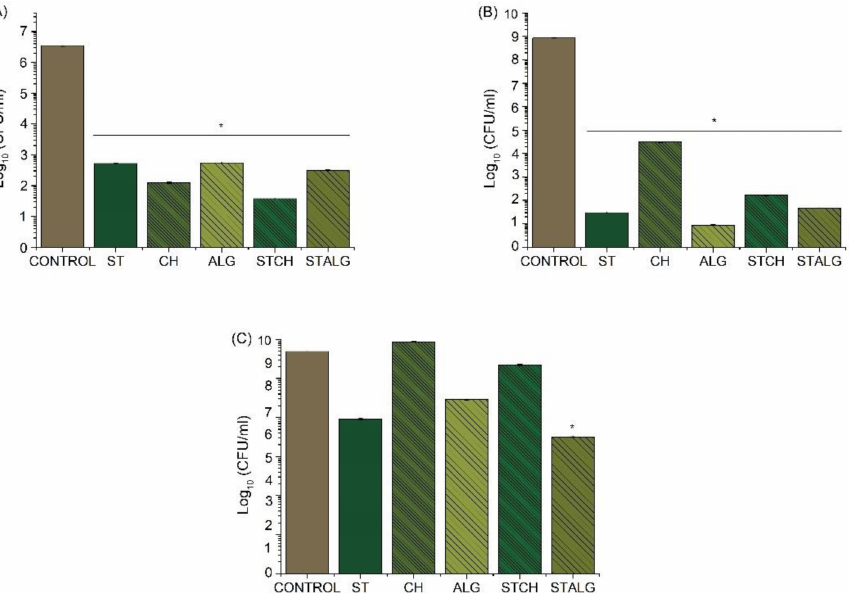
Figure 6. The effect of modified polysaccharide films on the viability of S. epidermidis cells ( A ), E. coli cells ( B ) and C. albicans ( C ); unpaired t -Test: * p <